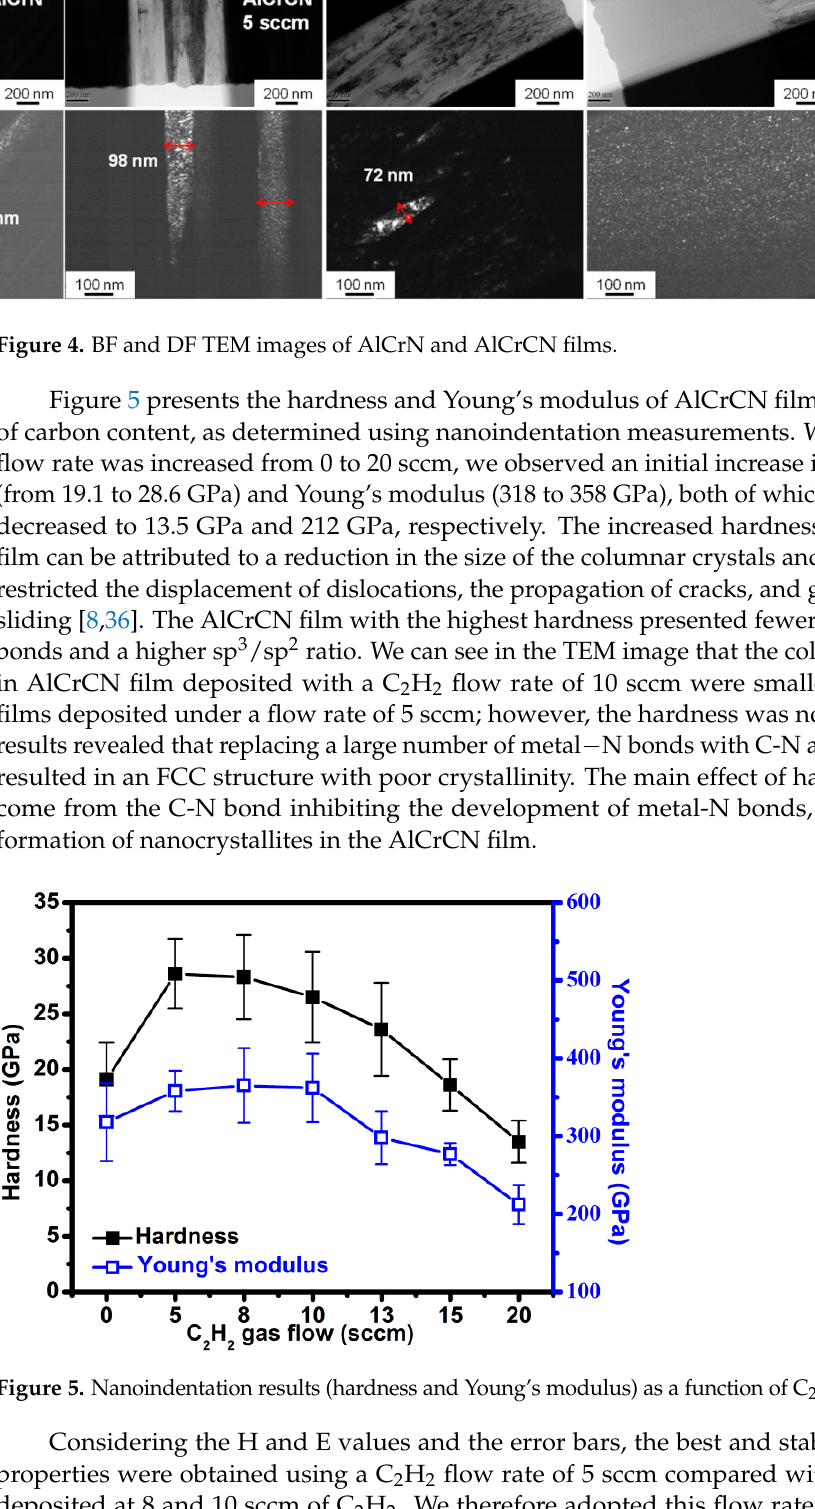
Figure 3. TEM image and SAED patterns of AlCrCN coatings as a function of C 2 H 2 flow (5 and 20 sccm).